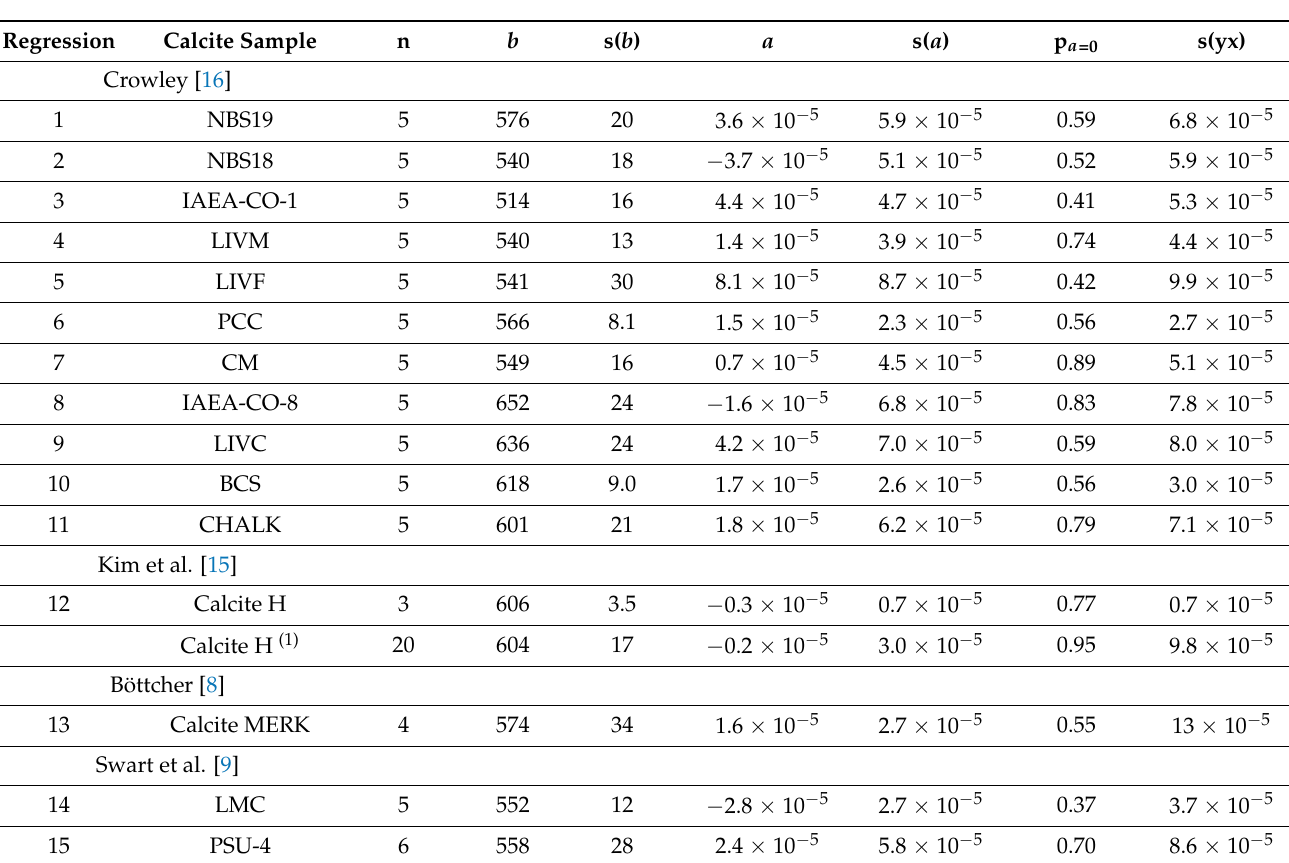
Table 1. Statistical data for the regressions different samples of low-Mg calcite